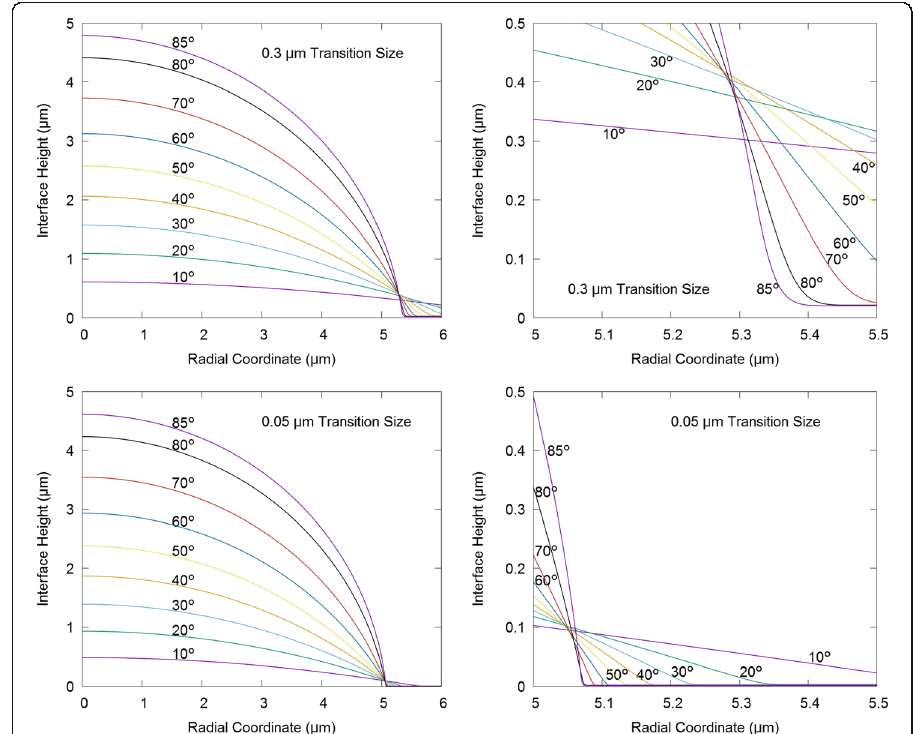
Fig. 6 Simulated bubble cross-sections for surface energies corresponding to sharp interface angles of 10° to 85° for transition size of 0.3 μ m ( top left ) and 0.05 μ m ( bottom left ), with enlarged triple junction regions ( top right and bottom right ,